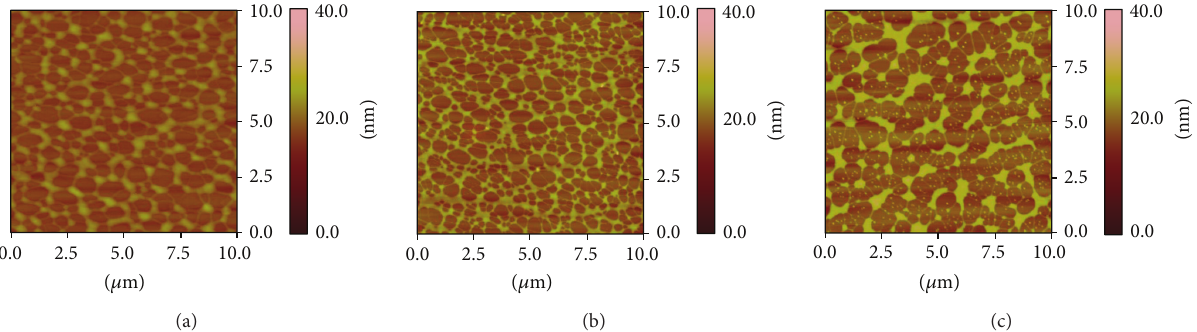
Figure 11: AFM images of 1500 ppm HAPAM with different BS-12 concentrations: (a) 0ppm BS-12, (b) 100ppm BS-12, and (c) 400 ppm BS-12. reduce the effect of polymer concentrations, the preparation concentration of polymers is 2 ppm in experiment. For the dilute polymer solution, ⟨𝑅 𝑔 ⟩ can be concluded through in solution; then some ⟨𝑅 𝑔 ⟩ are received under different surfactant concentrations in the same way. Their results are shown in Figure